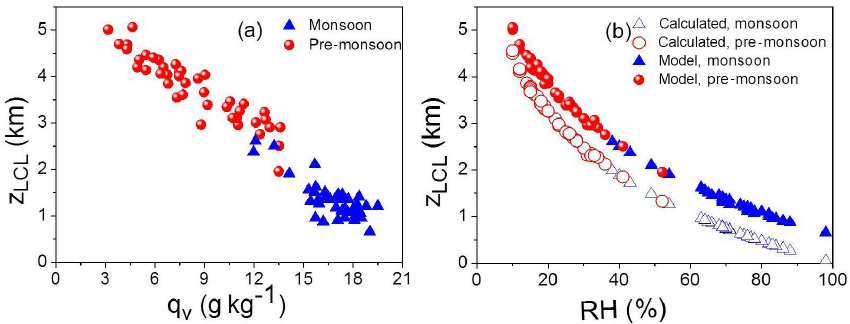
Figure 3. Variation of LCL height z LCL with (a) surface q v and (b) surface RH. Red/blue circles/triangles represent pre-monsoon/monsoon cases. Parcel-model-derived parameters (RH and LCL height) are shown as filled symbols. LCL heights derived using Eq. (3) are shown as empty